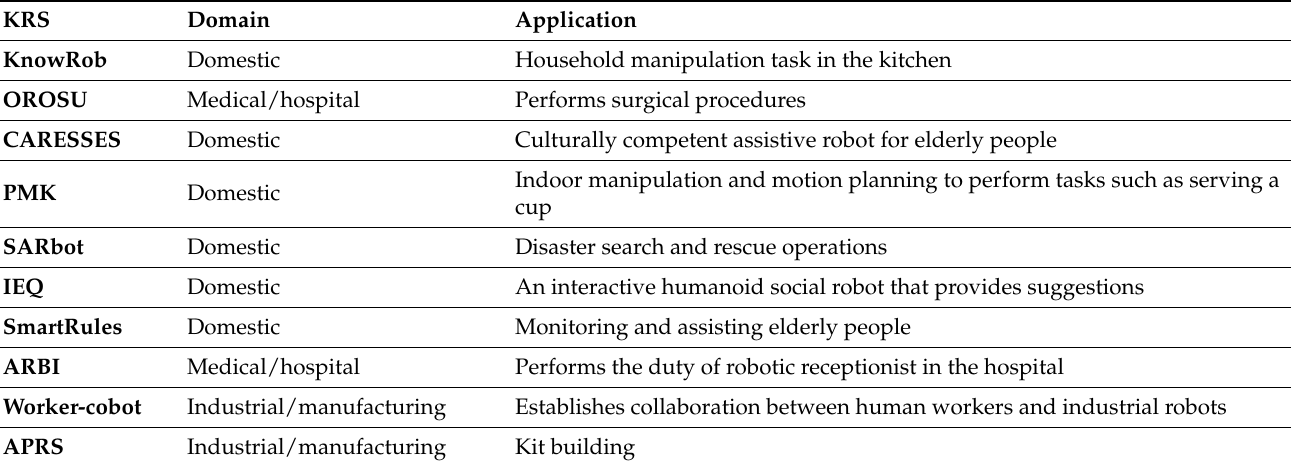
Table 3. KRSs: domain and application